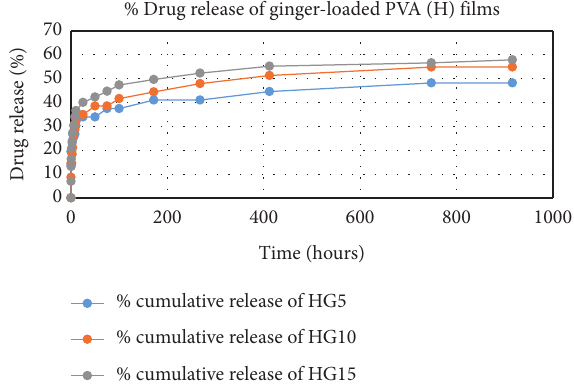
Figure 17: Drug release % of ginger-loaded PVA (H) films.